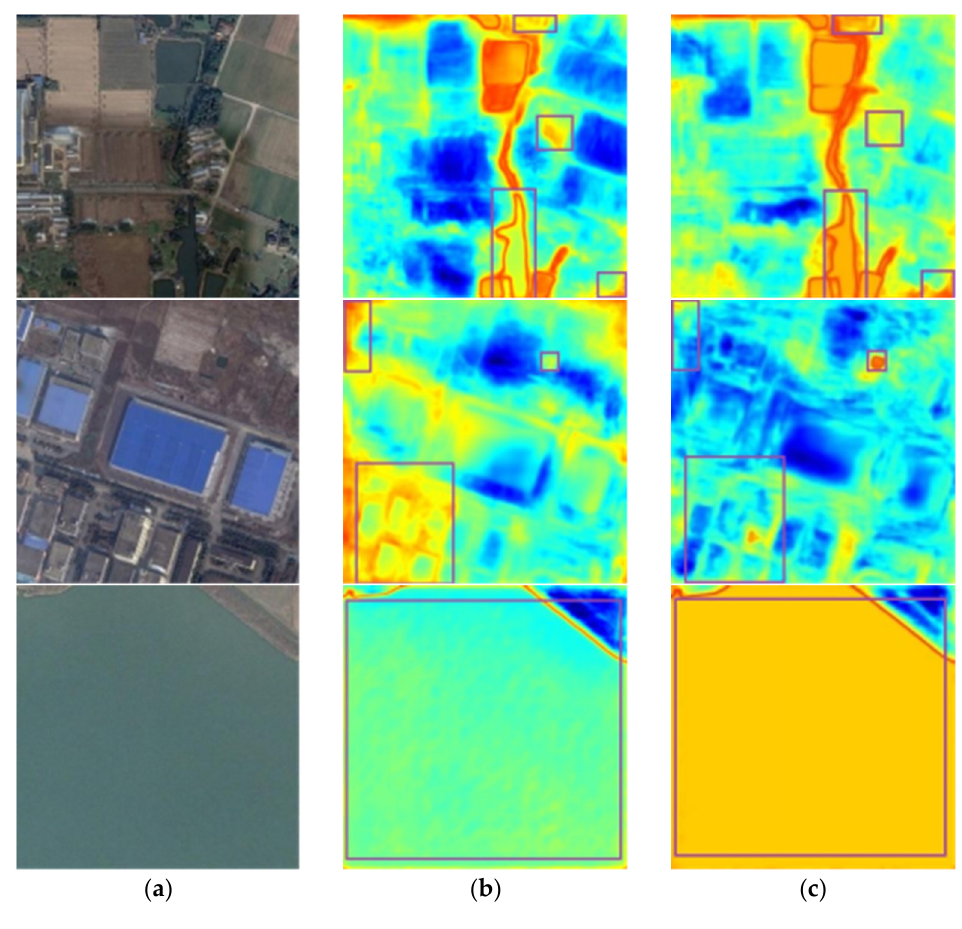
Figure 7. Visual comparison results of the SSA mechanism. ( a ) Image; ( b ) without the SSA mechanism; ( c ) with the SSA mechanism. The boxes circle the changes after adding SSA.